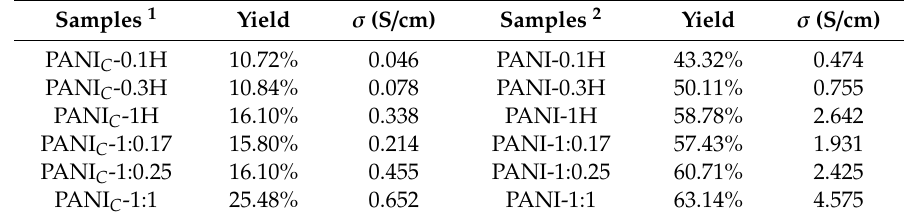
Table 2. The yields and electrical conductivity of PANIs synthesized by conventional heating and microwave-assisted chemical polymerization. Samples 1